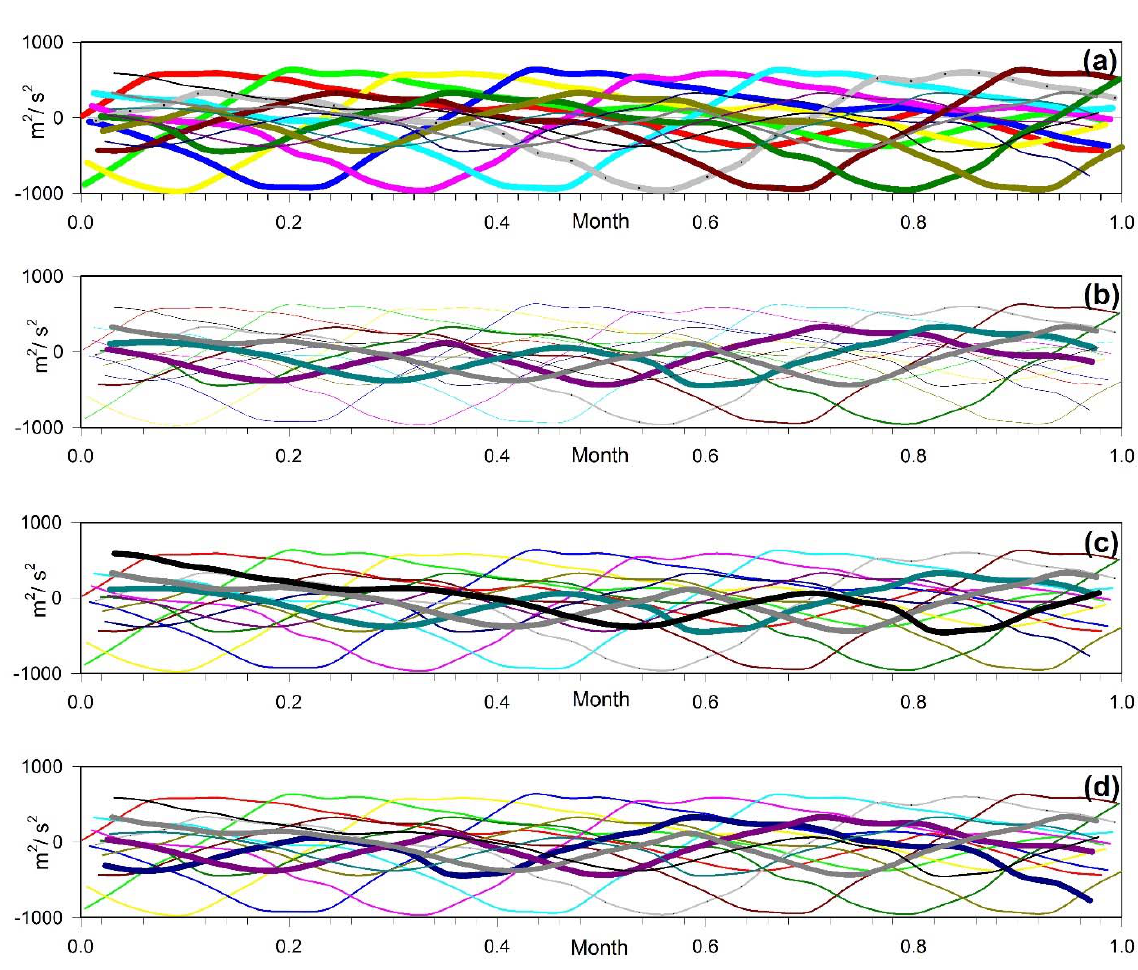
Figure 4. Panels ( a – d ) emphasize a subset of different combinations of envelopes (thick lines), showing that the modulation intensity of the sampled signal varies throughout the entire month and thus in space: We do observe different intensity stripes in the various GRACE models. The lower intensity signals (panels b – d ) correspond to the low magnitude disturbing potential.